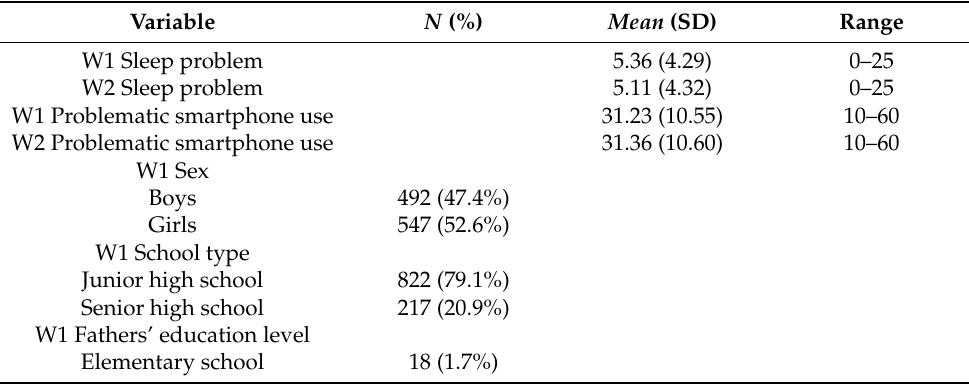
Table 1. Descriptive statistics of study variables ( n =